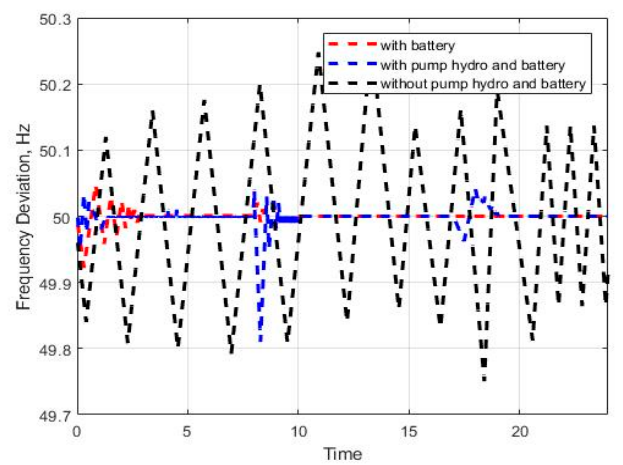
Figure 7. Frequency response of the microgrid without wind power full-day.